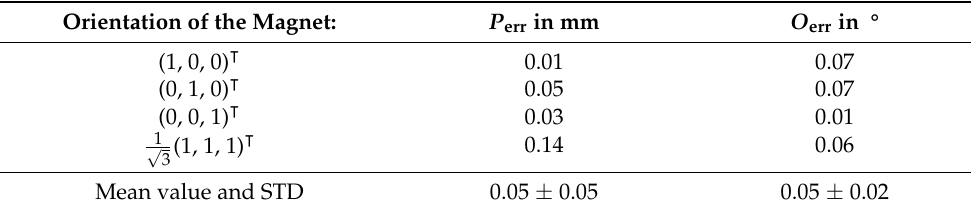
Table 2. Position P err and orientation O err errors and their mean value and standard deviation (STD) for the differential method for the four different orientations of the magnet under ideal conditions [32]. Orientation of the Magnet: P err in mm O err in ° (1, 0, 0)